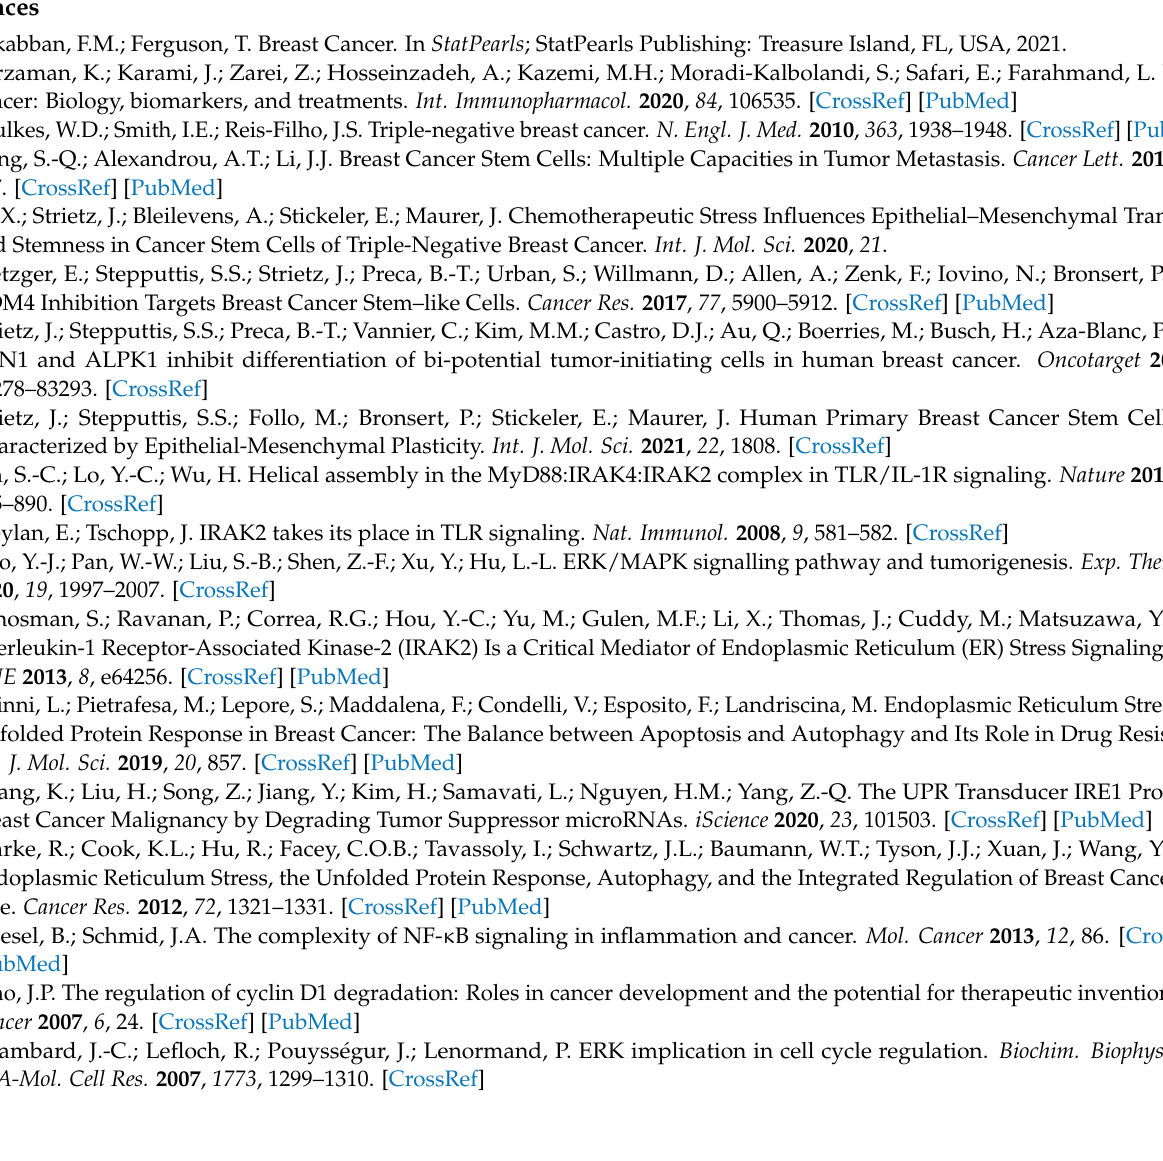
Figure A2. IRAK2 expression at the protein level in xenografts derived from BCSC1 and MDA-MB- 468. Relative quantification of the Western blot depicted in Figure 2B, representing IRAK2 expression in xenografts derived from control (CV) and IRAK2 knockdown (shIRAK2) BCSC1 or MDA-MB-468 cells. IRAK2 expression in each xenograft was normalised to the expression of the HKG GAPDH. Data are presented as means ± SEM (n = 6 for BCSC1 and n = 3 for MDA-MB-468); statistical analysis was performed using unpaired Student’s t -test. **, p < 0.01.